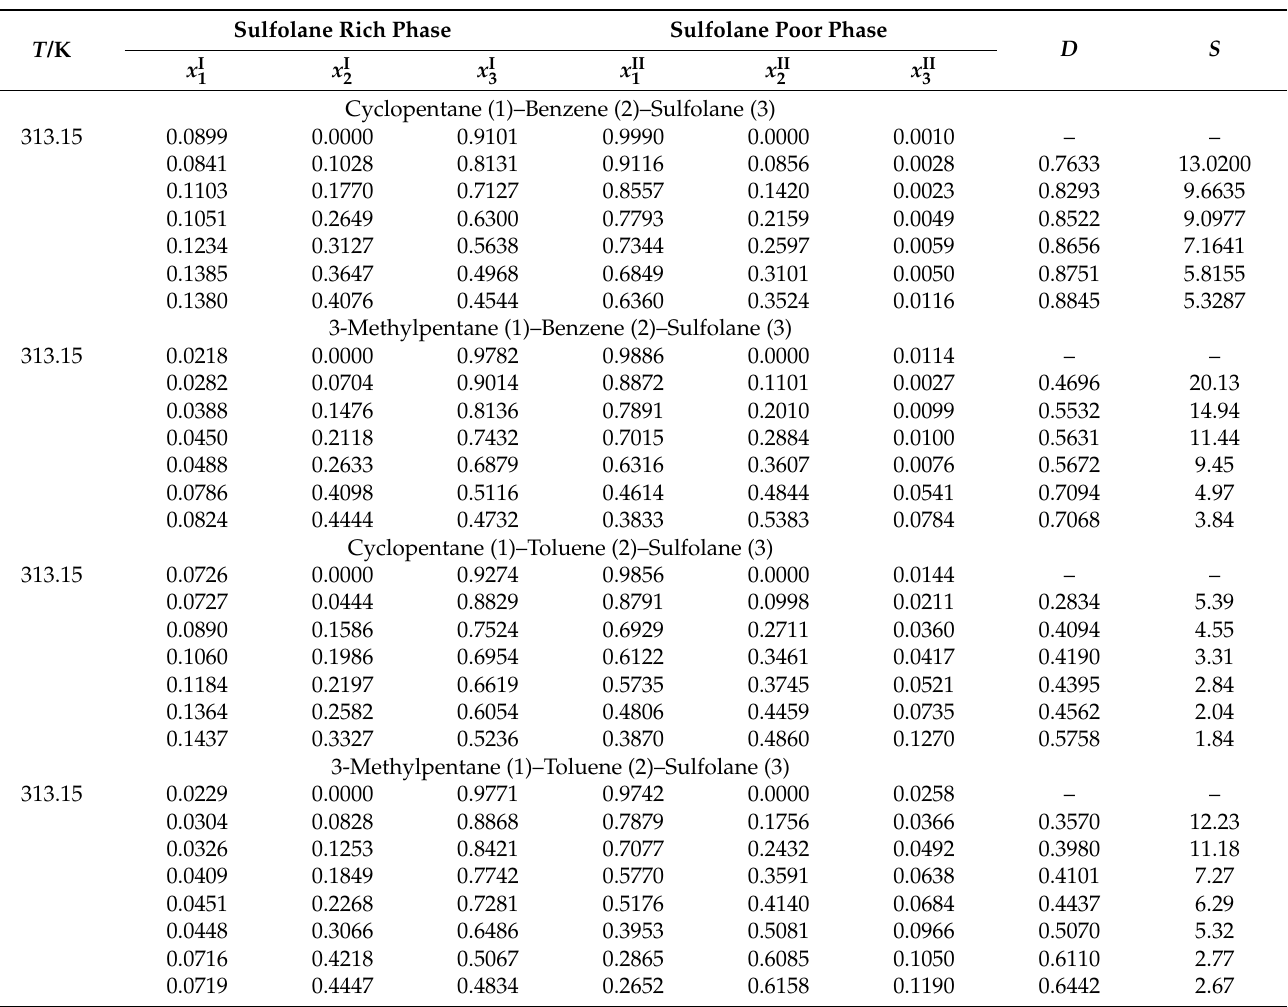
Table 1. Liquid–liquid equilibrium data (molar fraction) for non-aromatics (1)–aromatics (2)–sulfolane (3) ternary systems at 313.15 K under 101.3 kPa 1 .